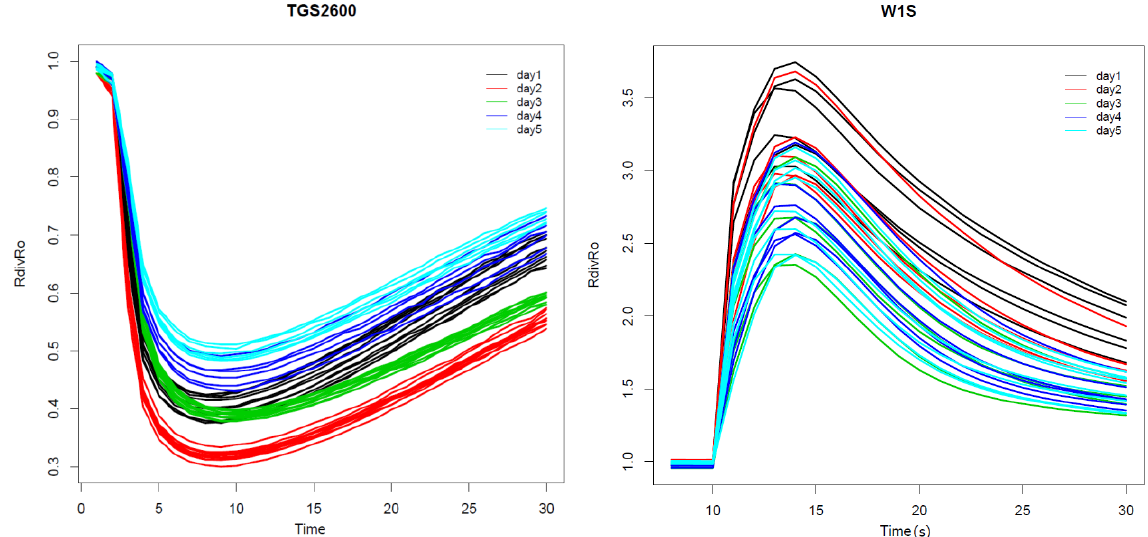
Figure 5. R/R curves for the TGS2600 sensors in the CAPINose and W1S ones in the o